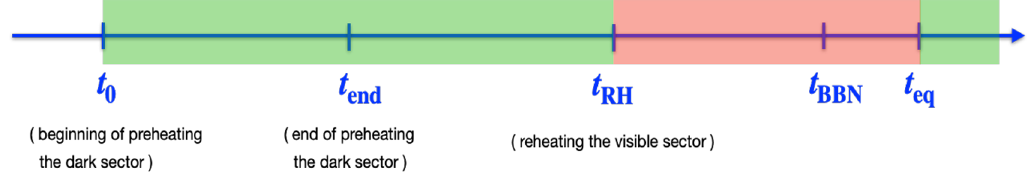
Figure 3 . Schematic timeline (not to scale) for the in(cid:13)aton preheating the dark sector and reheating the visible sector. From t 0 to t RH , the Universe has an early period of matter dominance with H / a (cid:0) 3 = 2 . From t RH to the matter-radiation equality time t eq , the Universe is radiation dominated with H / a (cid:0) 2 . The matter (radiation) dominant period is labeled in green (red)